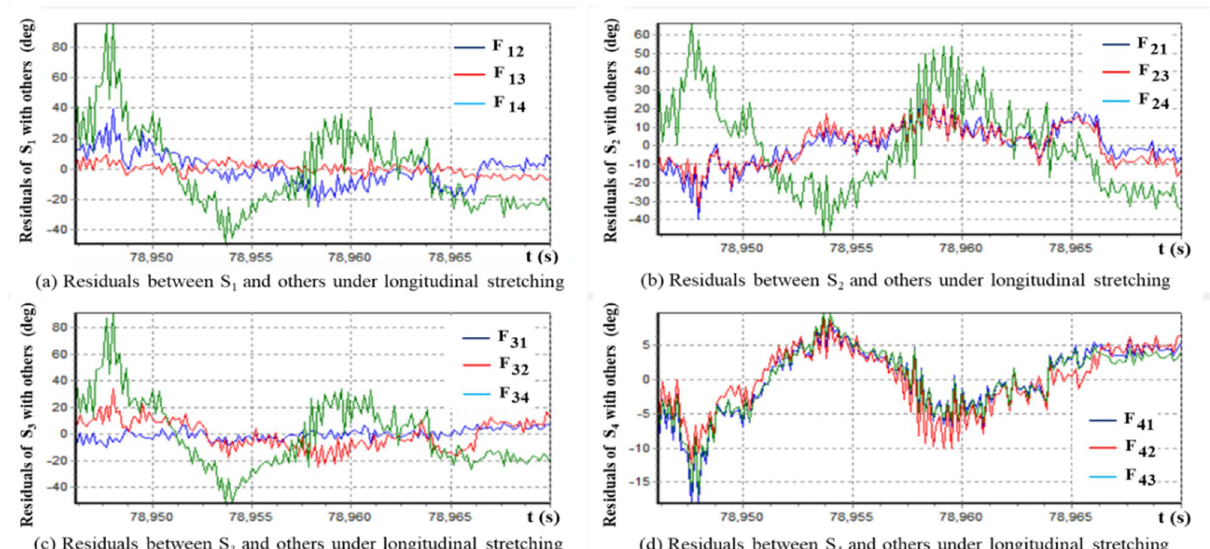
Figure 4. Plot of residual temperature difference based on longitudinal stretching